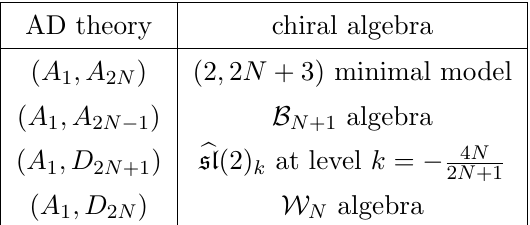
Table 6. Examples of Argyres-Douglas theories and corresponding chiral algebras. To be more precise, in the ( A 1 ; A 2 N (cid:0) 1 ) case, it is the subregular quantum Hamiltonian reduction of b sl ( N ) k at level k = (cid:0) N 2 = ( N + 1) [81, 82]. In the ( A 1 ; D 2 N ) case, it is the non-regular quantum Hamiltonian reduction of b sl ( N + 1) k with k = (cid:0) ( N (cid:0) 1) 2 =N [81]. For details about quantum Hamiltonian reduction, see